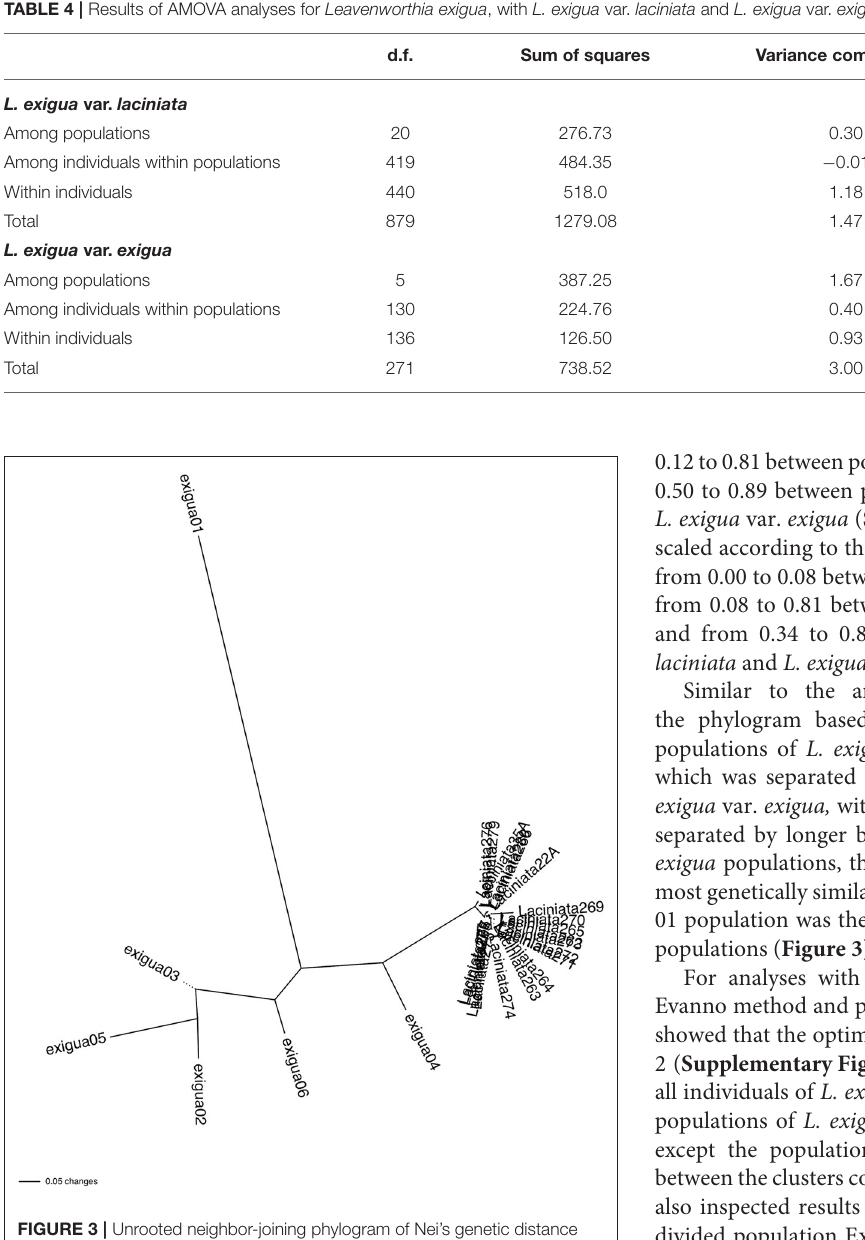
of L. exigua var. exigua and between populations of L. exigua var. laciniata and L. exigua var. exigua ( Supplementary Table 1 ).